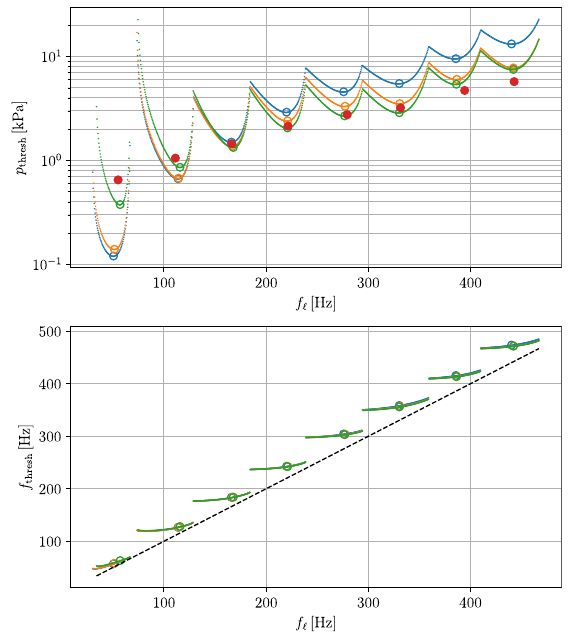
Figure 4. Results of the linear stability analysis with the constant, linear and inverse H -pro fi le described on Figure 5. Top and bottom plots represent respectively the threshold mouth pressure and the threshold frequency versus the lips ’ resonance frequency. Blue: H = h 0 , orange: H ¼ af l þ b , green: H / 1 = f l . Circles point out the minima of each U-shaped pattern on the top plot. Red points represent the experimental values of minimal threshold pressures given by [19]. The black dashed line on the bottom plot represents f thresh ¼ f l .